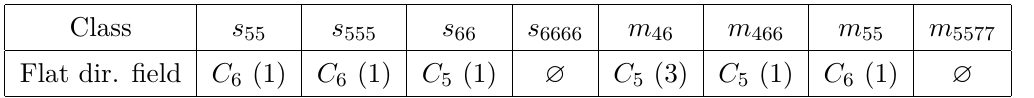
Table 3 . We consider all solution classes of [15] for which the stability of a solution will be analysed in section 5. For each of them, the dimensional reduction described in section 2.2 provides a finite set of fields { ϕ i } and a scalar potential V . We list in this table the fields ϕ i such that ∂ generically: this means ϕ i is a flat direction. While we actually provide in the table a p -form, the number in parentheses corresponds to the amount of its components remaining after the orientifold projections, thus to the number of scalar fields being generic flat directions in the solution class.